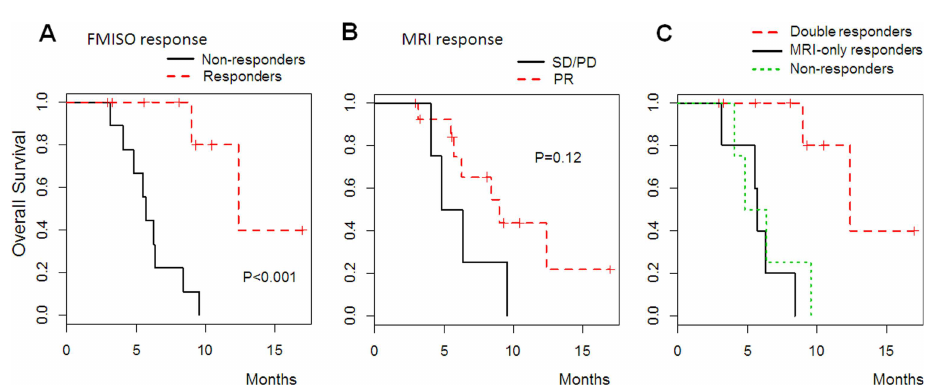
Fig 6. Overall survival according to treatment response by MRI and FMISO PET. Kaplan-Meier curves separated by FMISO response (A). Censoredobservation are marked with vertical bars. In addition, OS curves were shown accordingto MRI response (B) and three groups classified by MRI and FMISO response (C); MRI-FMISO doubleresponders (red broken line), MRI-only responders (black solid line), and non- responders (green dot line).